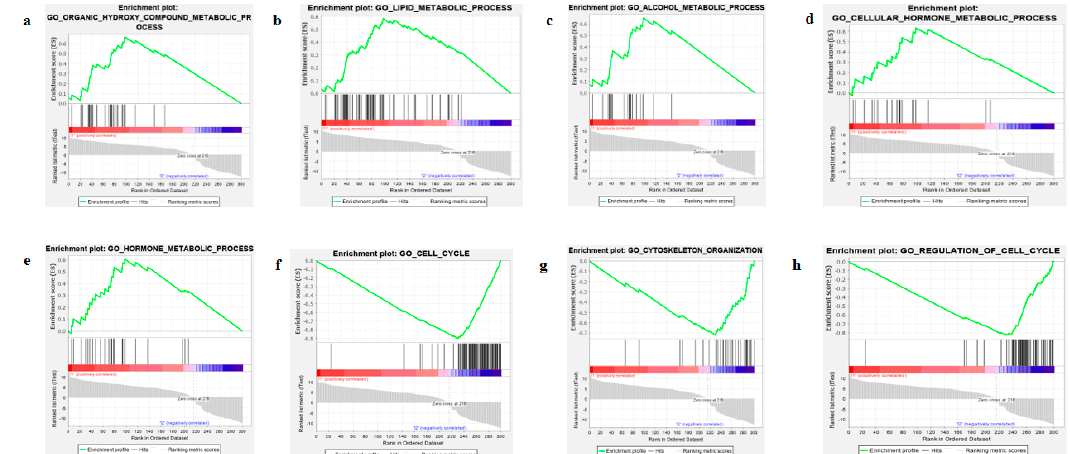
Figure 7. Gene set enrichment plot. GO-organic hydroxyl compound metabolic process ( a ), GO-lipid metabolic process ( b ), GO-alcohol metabolic process( c ), GO-cellular and hormone metabolic process ( d ), GO-hormone metabolic process ( e ), GO-cell-cycle ( f ), GO-cytoskeleton organization ( g ), GO-regulation of cell cycle ( h ) profile of the running ES score and positions of GeneSet members on the rank ordered lists.